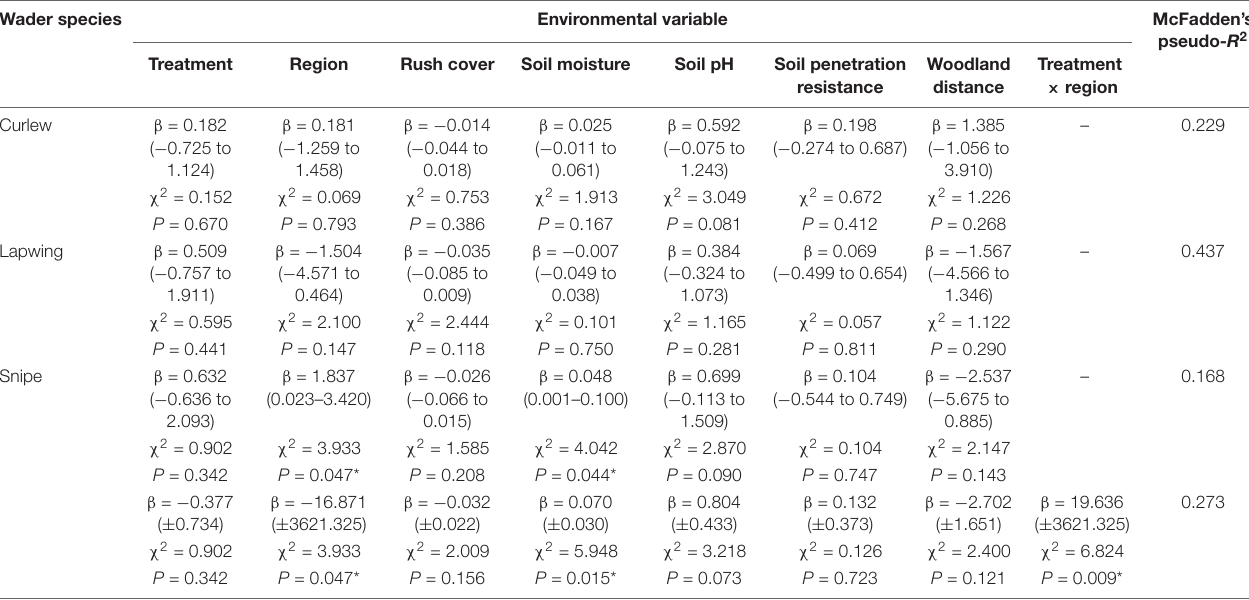
TABLE 1 | Generalised linear models of breeding wader pair density for Curlew, Lapwing, and Snipe – treatment, region, rush cover, soil conditions (moisture, pH, and penetration resistance), and woodland distance were included as predictor variables, with field size (natural logarithm transformed) included as an offset. Wader